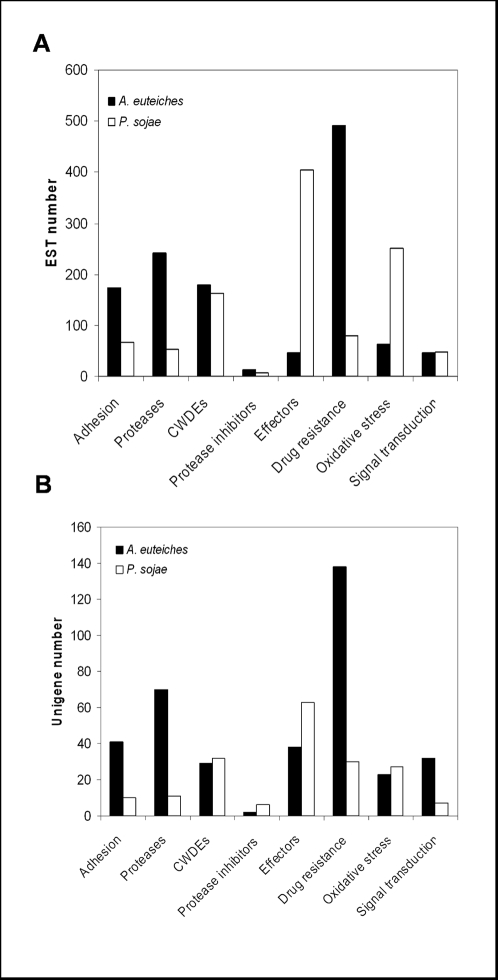
Classification of unigenes based on eight functional categories involved in pathogenicity.
A. euteiches unigenes (black bars) for which a putative function was assigned were classified into defined categories according to [17] and [16]. For each category the number of ESTs (A) and the number of unigene (B) is shown. For comparison to Phytophthora, analysis of a EST collection from P. sojae was added to the figure [16] (white bars).